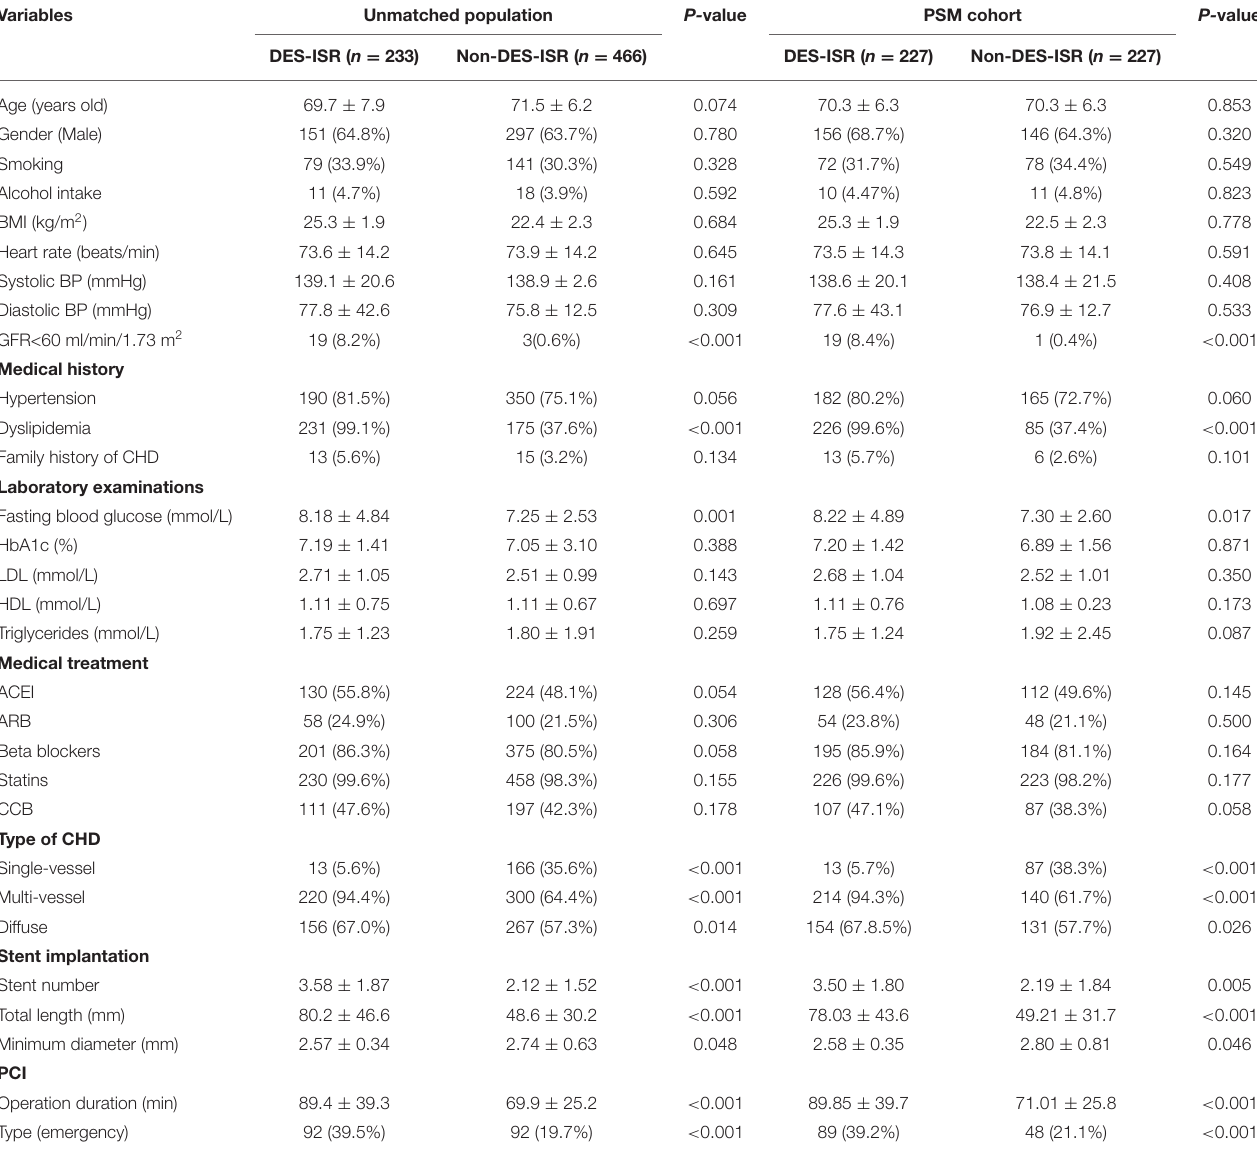
TABLE 1 | Baseline clinical characteristics of the study